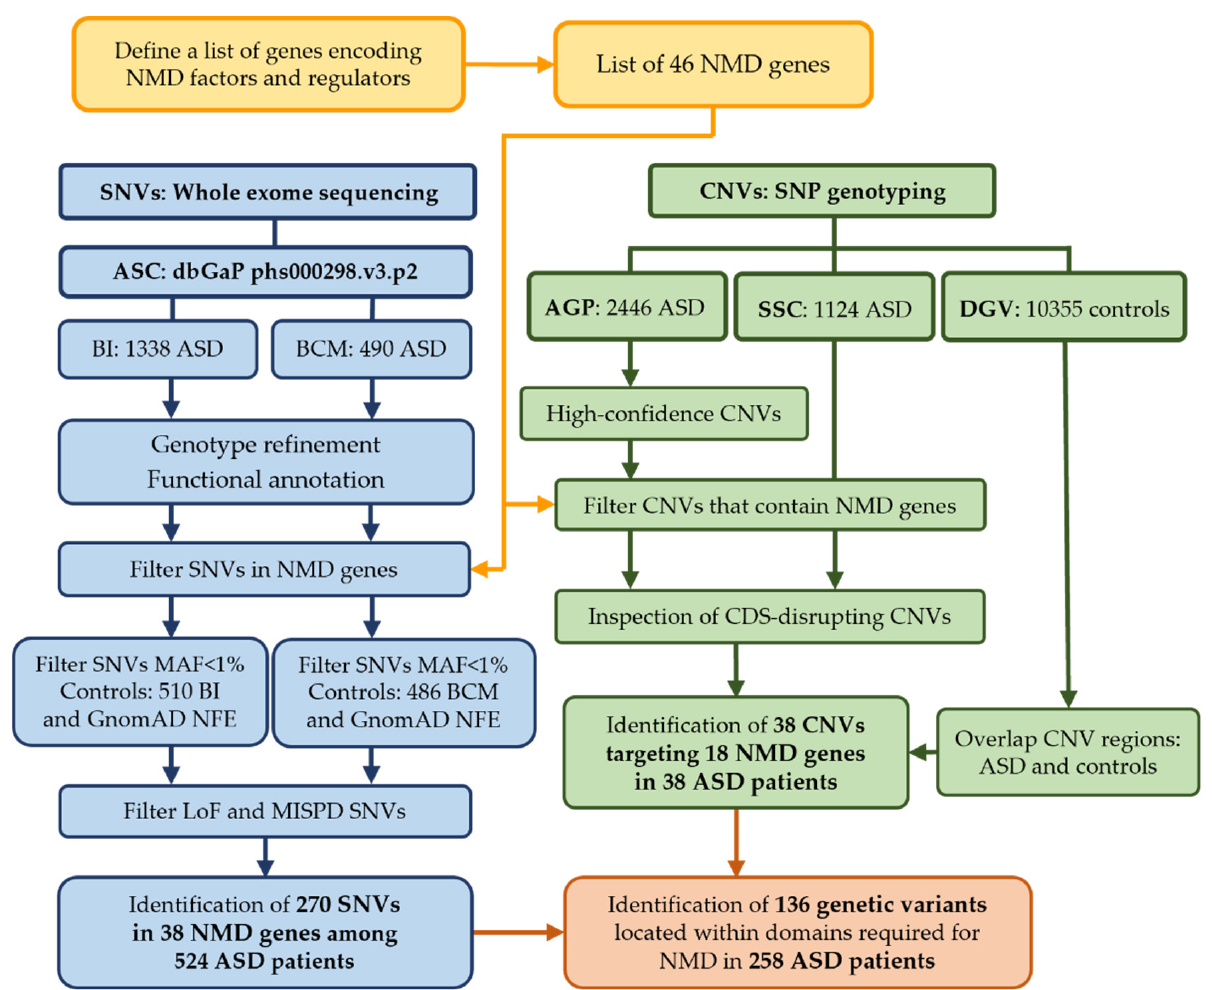
Figure 2. Overview of the analysis. The study began with the identification of 46 genes (Table 1) encoding proteins involved in the NMD pathway or in its regulation (yellow) that were used for further analyses. This workflow describes the analysis of SNVs obtained from ASC WES datasets for 1828 ASD patients (1338 BI and 490 BCM, blue) and the analysis of CNVs predicted from SNP genotyping data in 3570 ASD patients from AGP (2446) and SSC (1124) datasets (green). Analysis proceeded separately for CNVs and SNVs to identify variants in NMD genes and ended up with the identification of 270 SNVs (Figure 3) and 38 CNVs (Table 2) in 524 and 38 ASD probands, respectively. Protein domains affected by SNVs or CNVs were then identified (orange), and a total of 136 genetic variants were located within regions required for NMD in 258 ASD patients (Table 3). Legend: SNVs, Single Nucleotide Variants; CNVs, Copy Number Variants; ASC, Autism Sequencing Consortium; AGP, Autism Genome Project; SSC, Simons Simplex Collection; BI, Broad Institute; BCM, Baylor College of Medicine; DGV, Database of Genomic Variant; CDS, coding sequence for protein; MAF, Minor Allele Frequency; NFE, Non-Finnish European; MISPD, missense variants predicted to be damaging and deleterious; LoF,